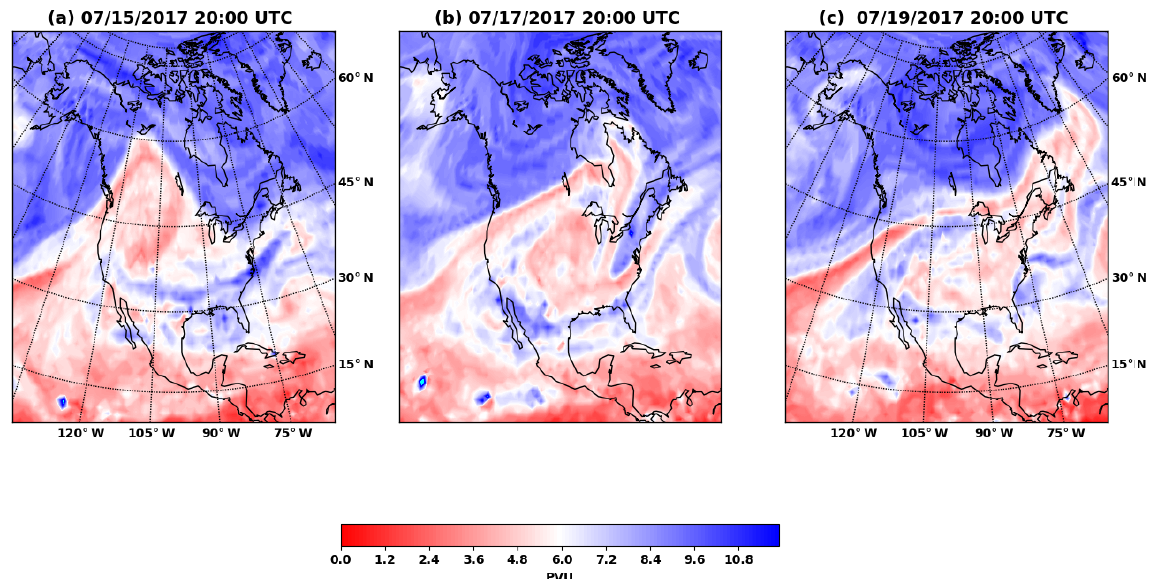
Figure 2. Potential vorticity on the 380K isentropic surface on 15, 17, and 19 July 2017 at 20:00UTC, showing a Rossby wave-breaking event several days prior to the SHOW measurements.